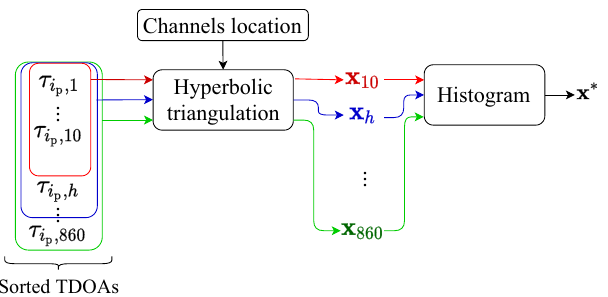
Fig. 6 Blind source location strategy. First, the TDOAs are ordered according to their reliability indicator κ i process is applied. We de fi ne the vector x h ¼ ^ x h ; ^ y h ; ^ v h